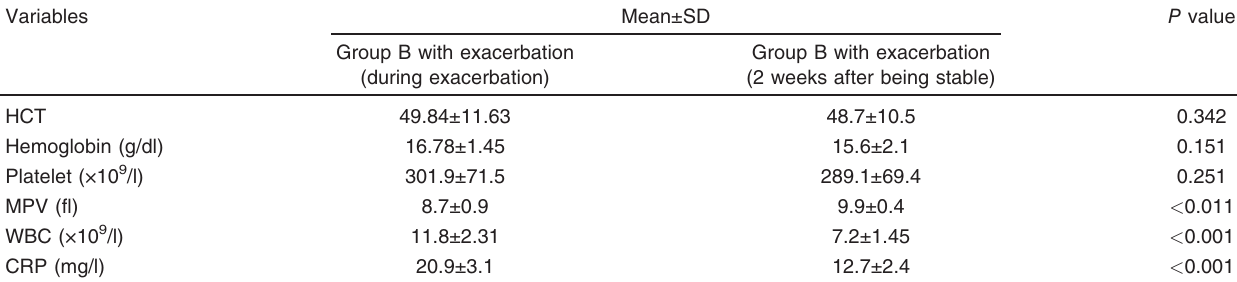
Table 3 Laboratory characteristics during the stable period and during COPD exacerbation in group B patients (6 weeks after recovery) Variables